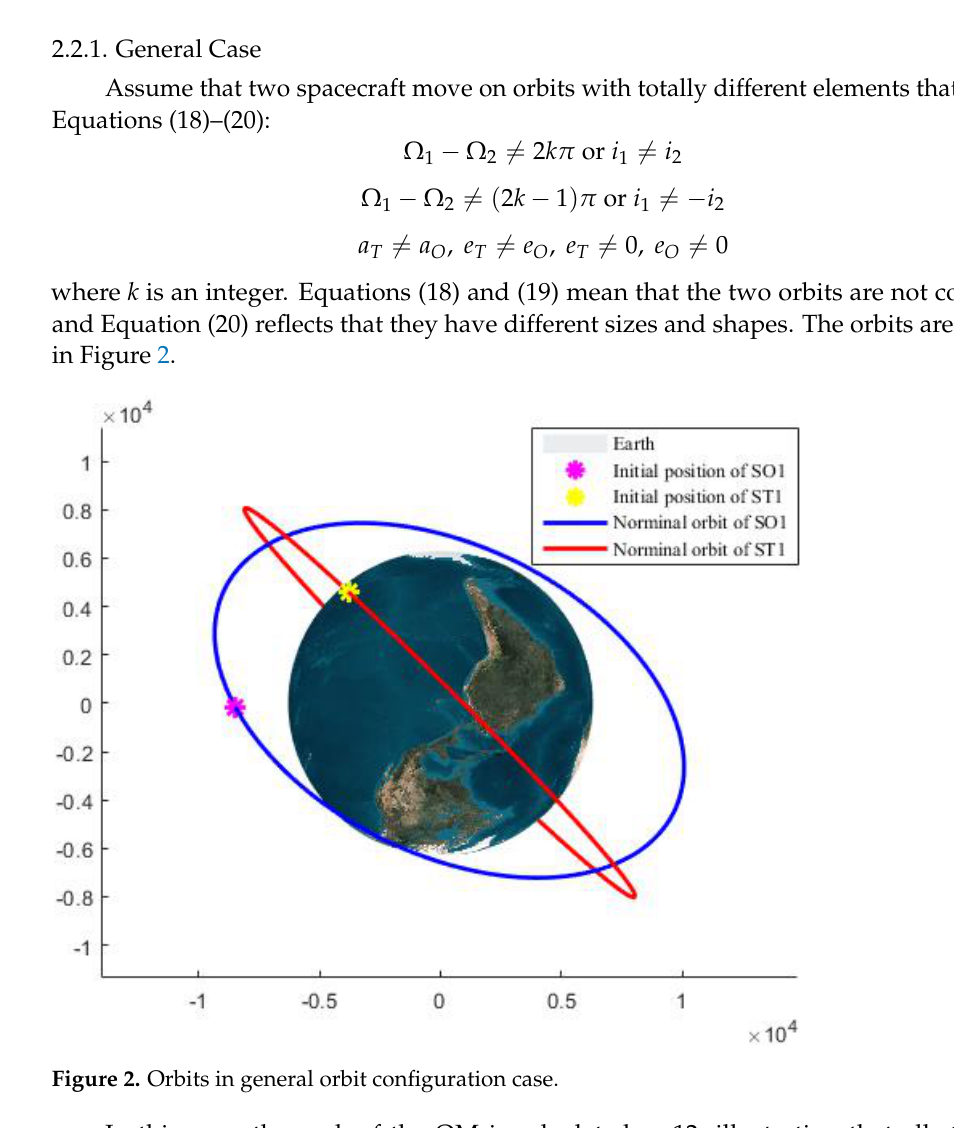
Table 2. Initial deviations of orbital elements.